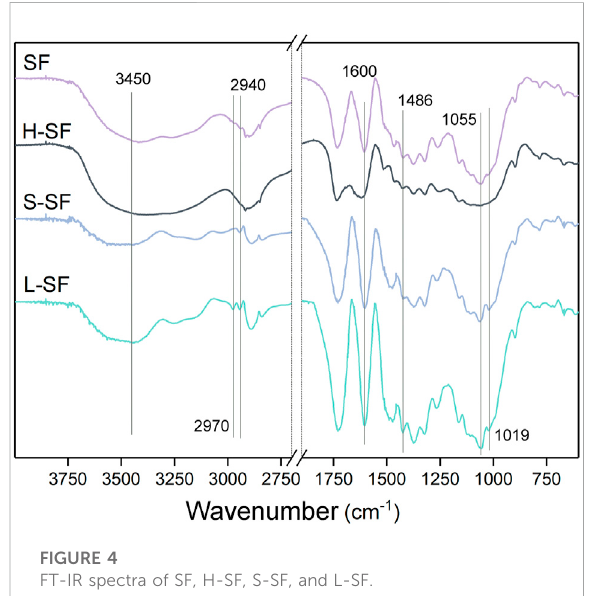
FIGURE 4 FT-IR spectra of SF, H-SF, S-SF, and